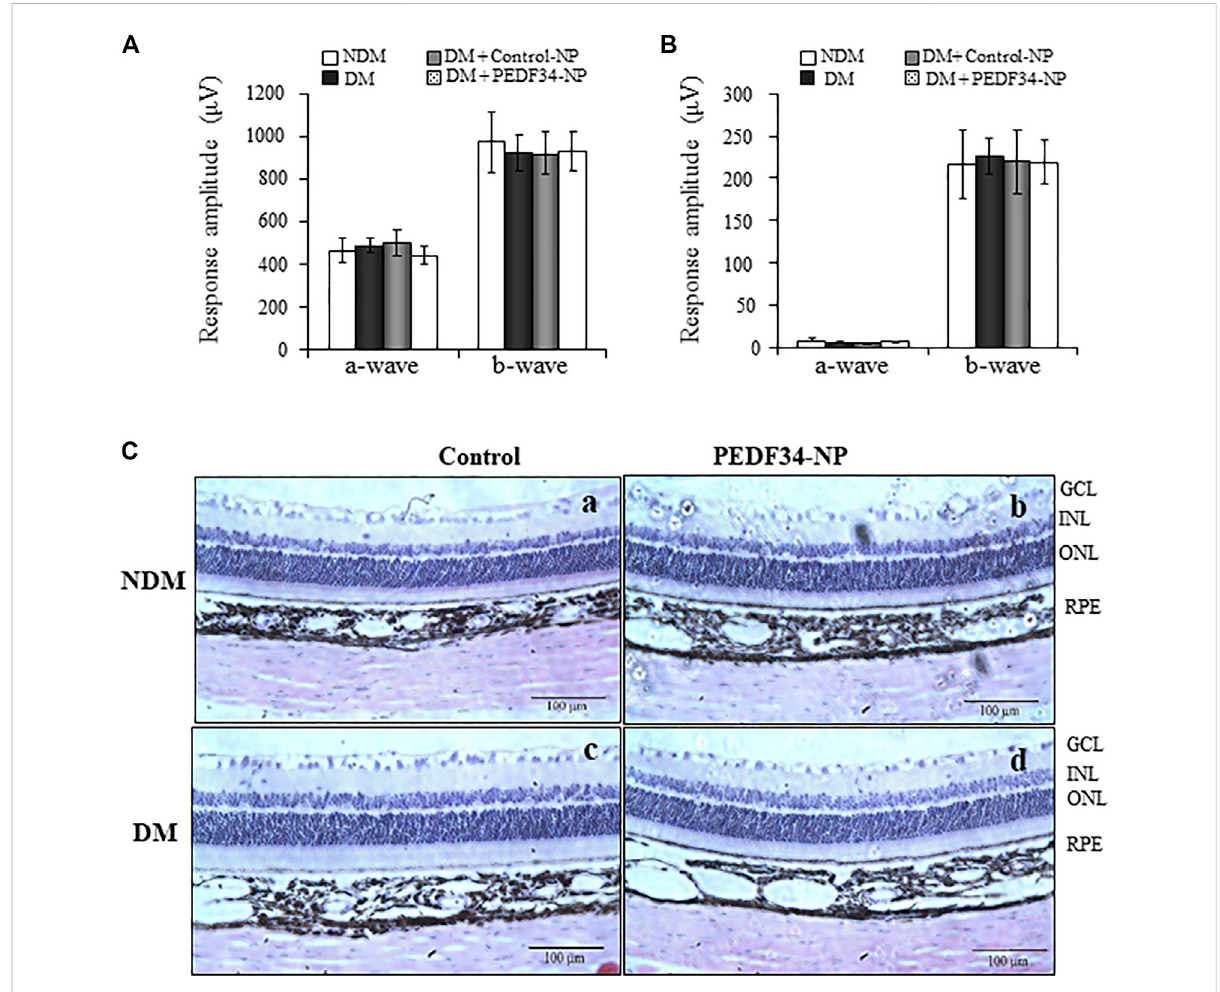
FIGURE 7 NochangesinERGresponseandretinalhistologyinresponsetoPEDF34-NPinjection.ScotopicandphotopicERGwererecordedfromsixrats at 4 weeks after the intravitreal injection of PEDF34-NP and Control-NP as indicated. Amplitudes of a- and b-waves from scotopic (A) and photopic (B) ERG were averaged and compared (mean ± SD, n = 6). (C) Representative images of retinal section stained with H&E from non-diabetic rats (A) , non-diabetic rats (NDM) injected with PEDF34-NP (B) , diabetic rats (DM) (C) , and diabetic rats injected with PEDF34-NP (D)